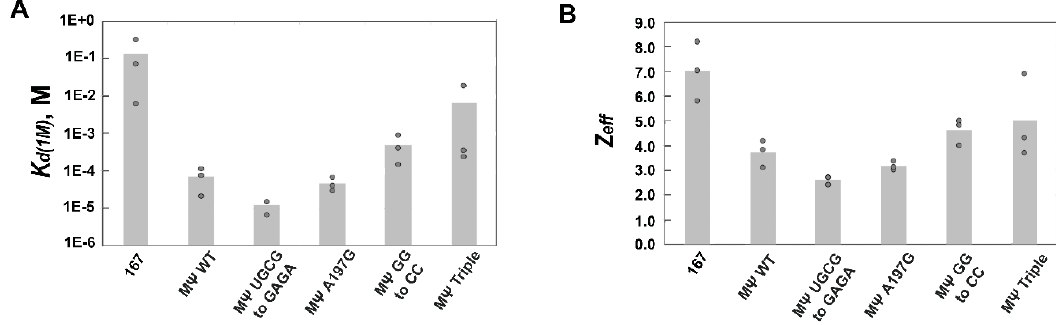
Figure 4. Bar graphs of K d(1M) values ( A ) and Z eff values ( B ) determined from salt ‐ titration assays with RSV Gag ∆ PR and RSV 167, WT M Ψ , and M Ψ RNA mutants. Values of three trials performed in each case are shown with the height of the bar indicating the mean value. Table 3. Binding parameters determined from FA salt ‐ titration assays of WT Gag proteins with non ‐Ψ RNA, WT Ψ , and mutant Ψ RNAs.